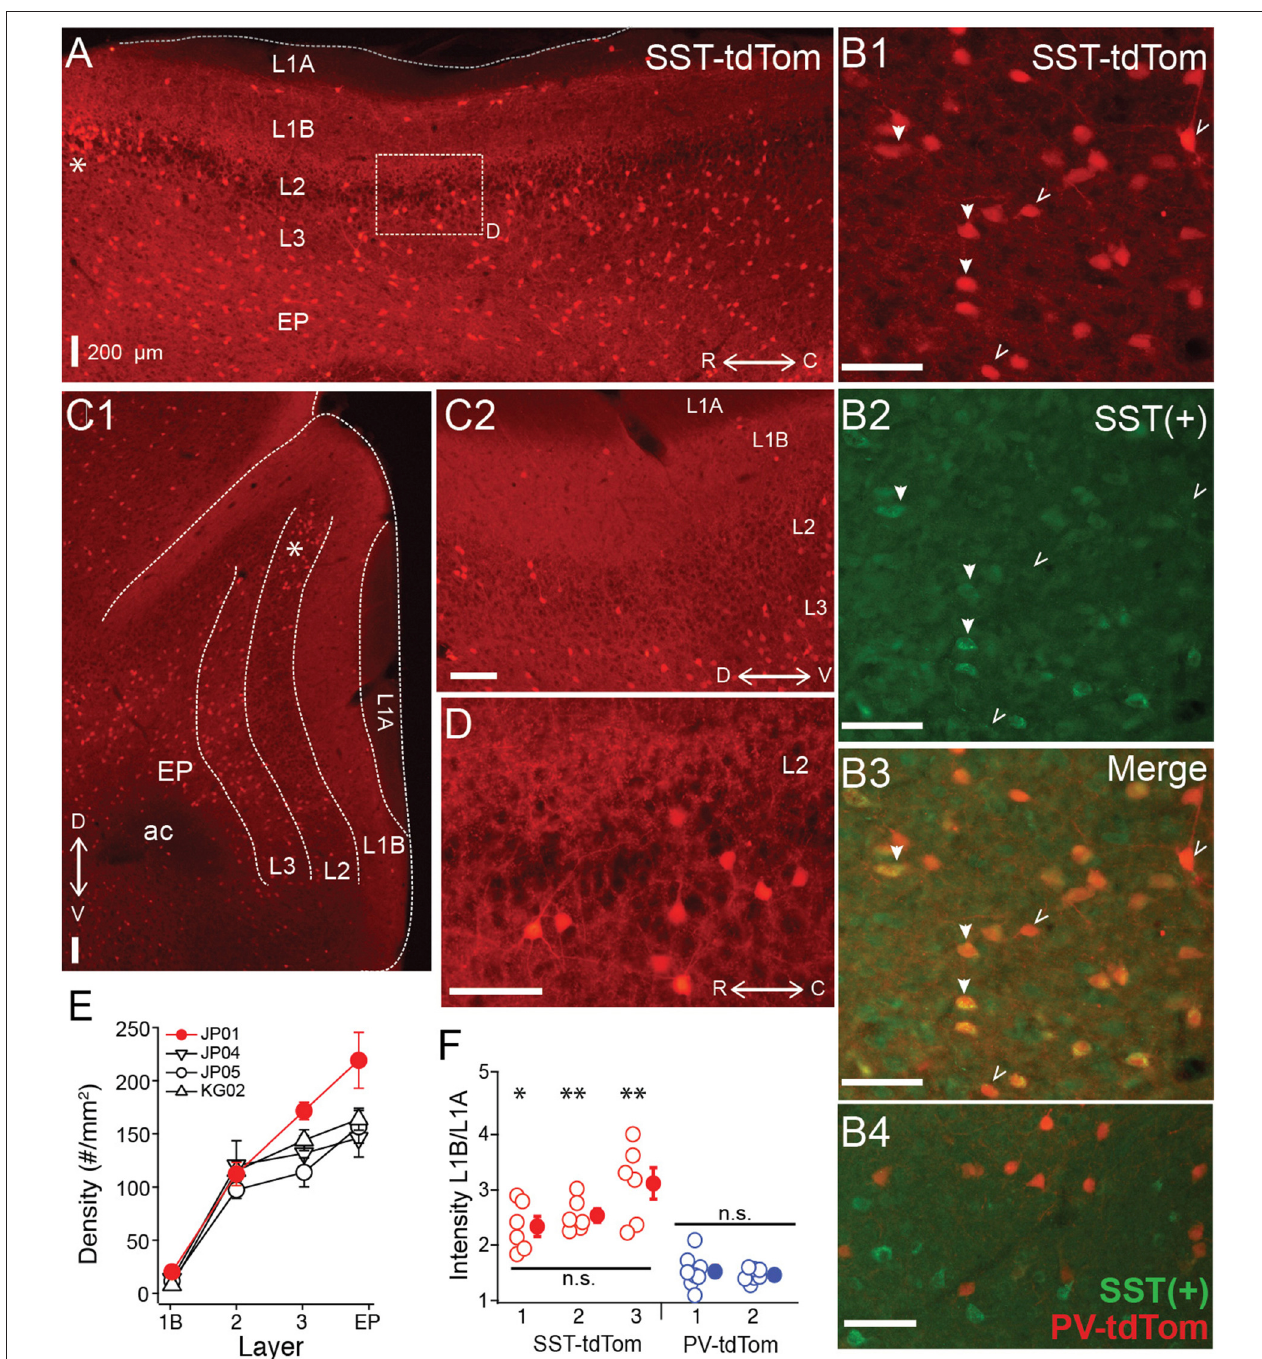
FIGURE 1 | Distributions of SST-cre cells in anterior piriform cortex. (A) Sagittal section of anterior piriform cortex from an SST-tdTom mouse (mouse #JP01). Lamina are labeled (L1A, L1B, L2, L3, EP), asterisk (*) corresponds to dorsal/rostral L2 density of SST-cre cells. 4x magnification, Scale bar: 200 µ m. (B) Co-expression of SST-tdTom cells with anti-somatostatin immunolabeling [SST( + ), green]. SST( + ) cells are shown with filled arrows while SST( − ) cells are labeled with open arrows (20x, scale bars 100 µ m; B1 ) SST-tdTom expression (red; B2 ) SST-immunolabeling (green; B3 ) Merge of (B1,B2) showing co-expression (yellow). (B4) Minimal overlap of PV-tdTom (red, mouse KM04) and SST( + ) cells (green). (C1) Coronal section from opposite hemisphere of mouse #JP01 shown in (A) . Labels as in (A) , 4x magnification, Scale bar: 200 µ m. (C2) Enlarged (10x) area of (C1) showing tdTom fluorescence in L1B corresponding to projections from SST-cells. Scale bar: 200 µ m. (D) Enlarged (20x) area of box shown in (A) . Scale bar: 100 µ m. (E) Average density of SST-cells in each layer for four different mice from two different litters (denoted JP, KG). Points shown in red correspond to data from mouse #JP01 shown in panels (A) and (C1,C2) . (F) Ratio of fluorescence in L1B:L1A for three SST-tdTom mice and two PV-tdTom mice. Each point corresponds to one coronal section. The fluorescence ratio did not significantly differ between SST-tdTom mice but was significantly higher in individual SST-tdTom vs. PV-tdTom mice (* p < 0.05; ** p < 0.01, ANOVA-Welch). ac, anterior commissure.